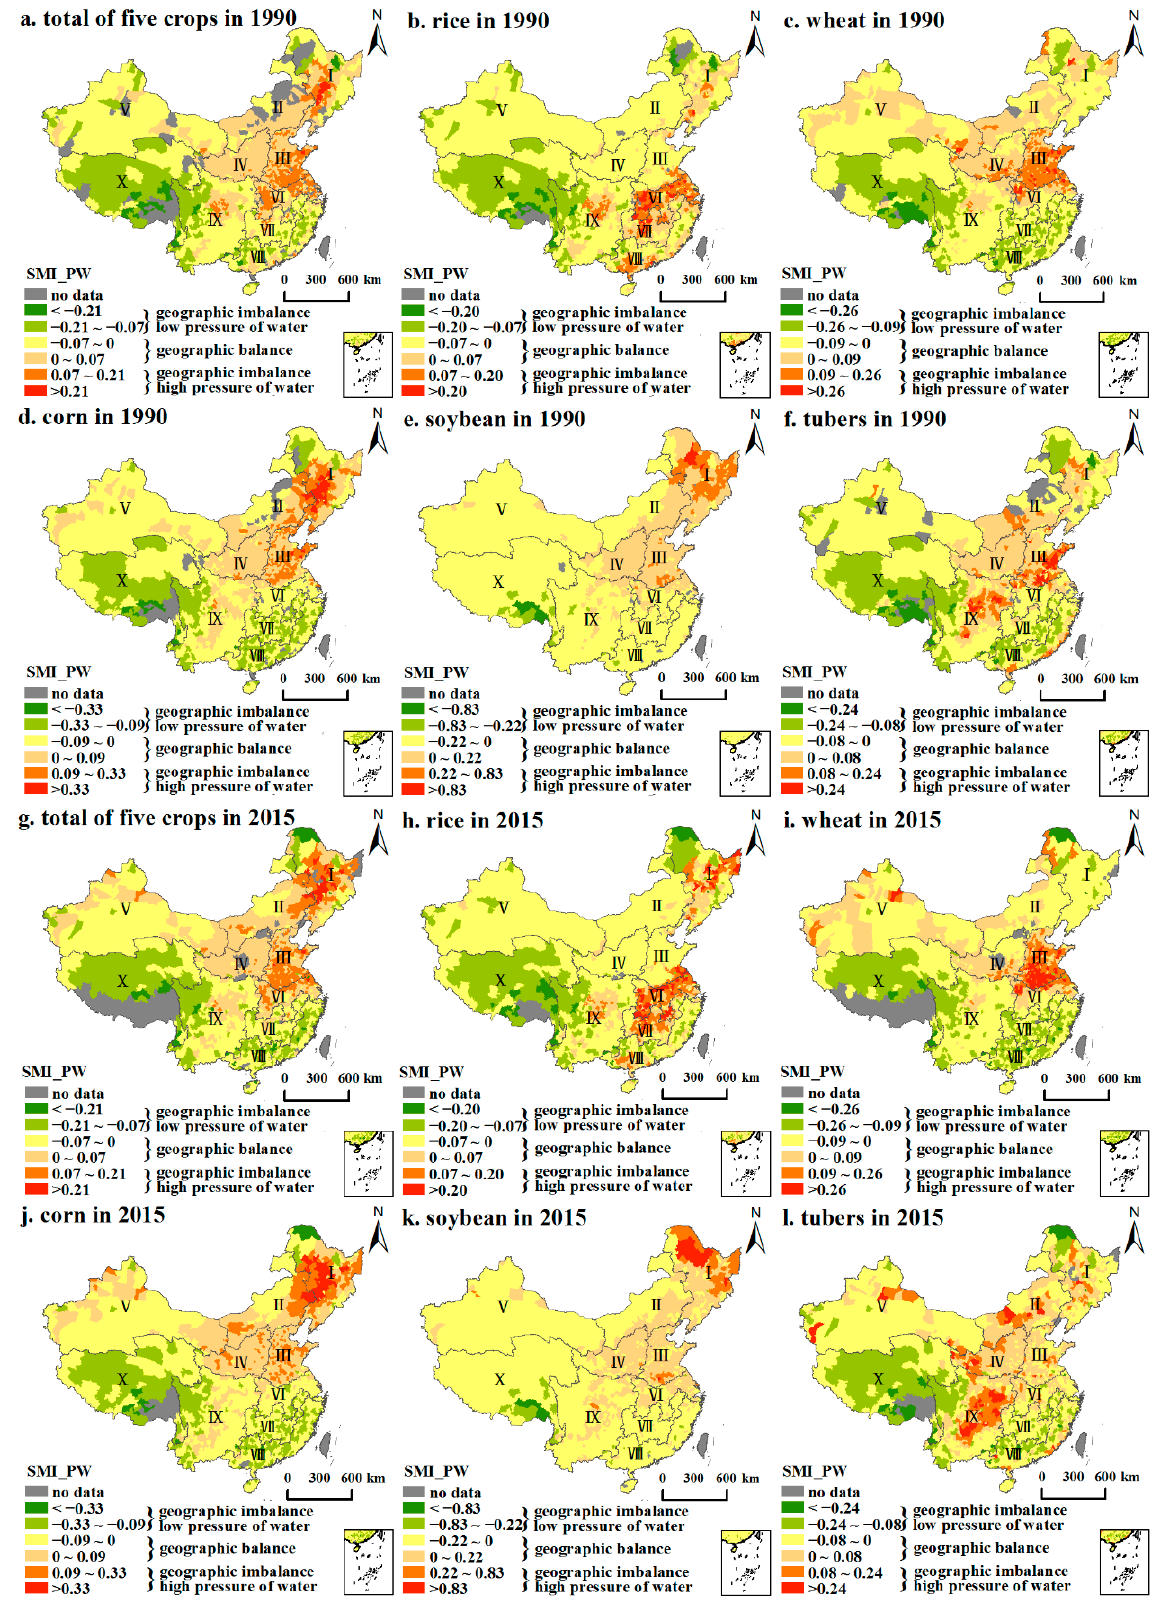
Figure 7. Geographic imbalances between crop production and water resources in the period 1990–2015.